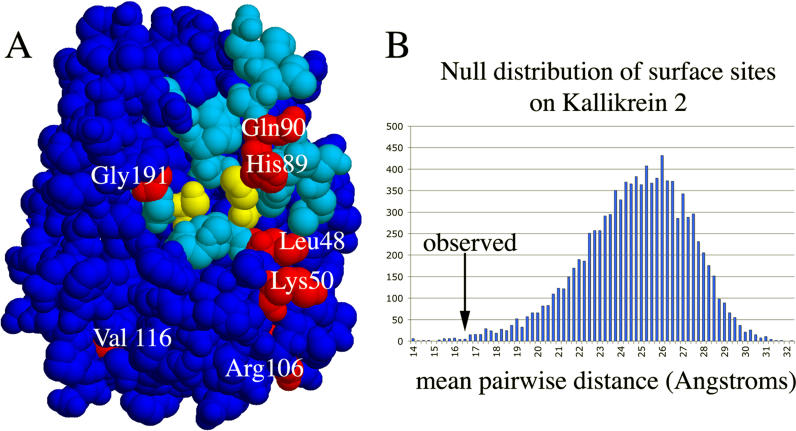
Positive Selection at Sites Involved in Substrate Binding in KLK2(A) Several amino acid sites predicted to be under positive selection (red) are near the protease active site (yellow). Three selected sites are found in known structural components of kallikrein proteins (light blue residues): Gly191 is part of the S1 substrate binding pocket, and His89 and Gln90 are part of the kallikrein loop [30]. Selected sites are labeled with the human residue on this threaded model.(B) Positively selected sites are significantly clustered on the surface of KLK2. The observed mean pairwise distance between predicted positively selected sites is significantly lower than random sets of surface sites (p = 0.0043). This spatial clustering suggests that positive selection acted during KLK2 evolution to alter substrate binding.